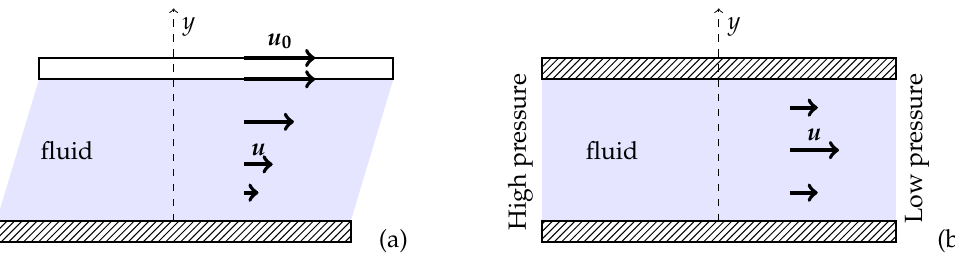
Figure 9. ( a ) Cartoon of the plane Couette flow setup. A fluid is contained between two plates, both normal to the y -axis. The bottom plate is fixed, as illustrated by hashes. The upper plate is moving at a given velocity u 0 . ( b ) Cartoon of the plane Poiseuille flow setup. A fluid is contained between two plates, both normal to the y -axis and both fixed. The pressure is higher at the inlet than at the